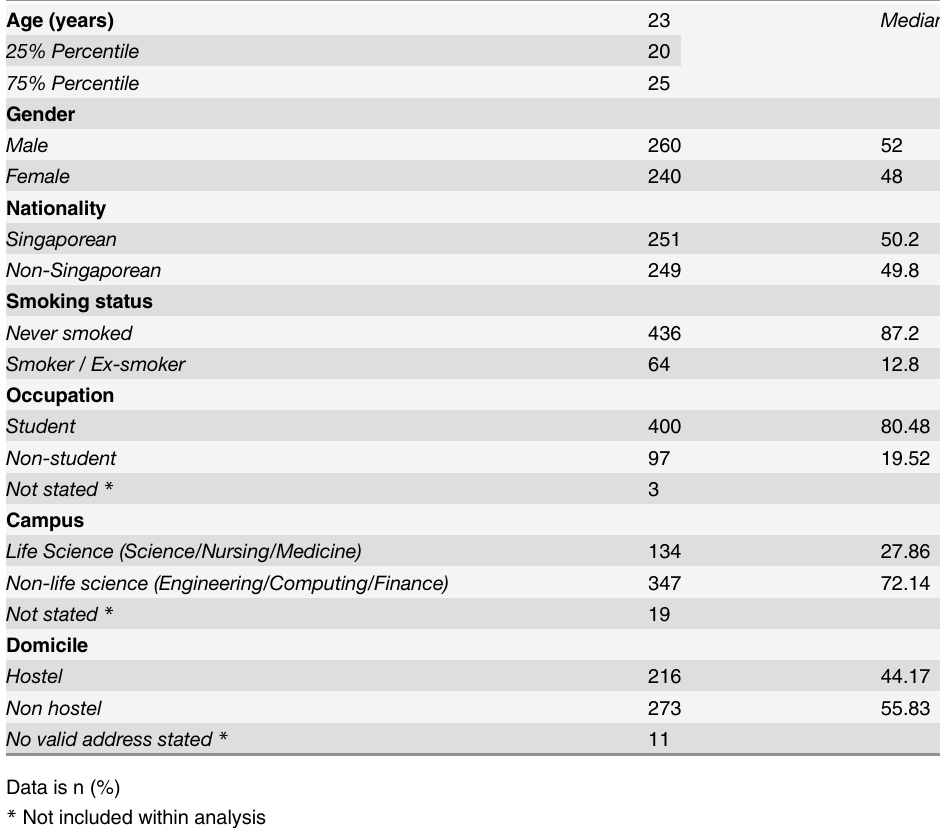
Table 1. Characteristics of Study